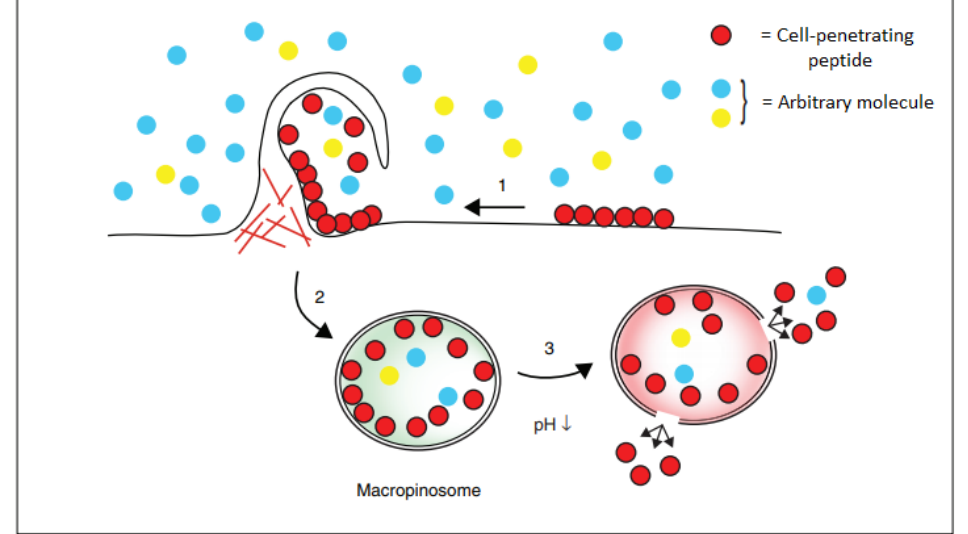
Figure 5. Pinocytosis mechanism